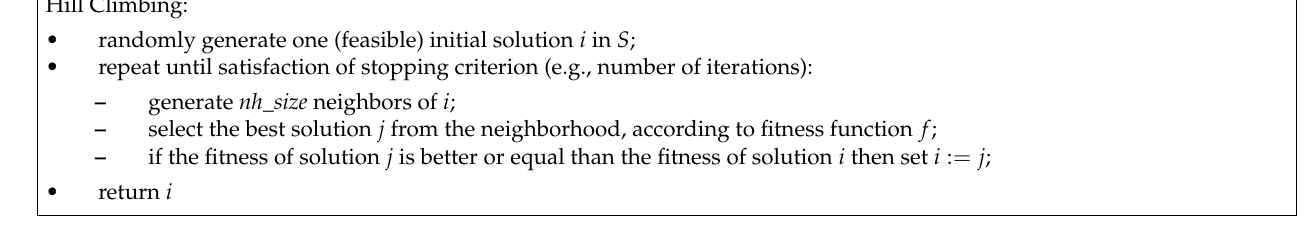
Figure 3. Procedural steps of hill climbing.